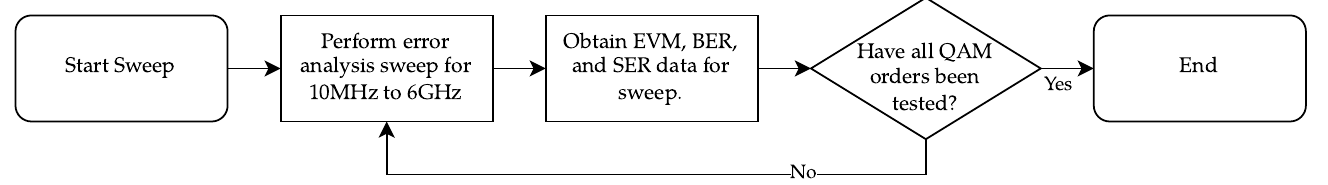
Figure 5. Flowchart of the experimental process specific to the VST. The output power is configured before commencing the